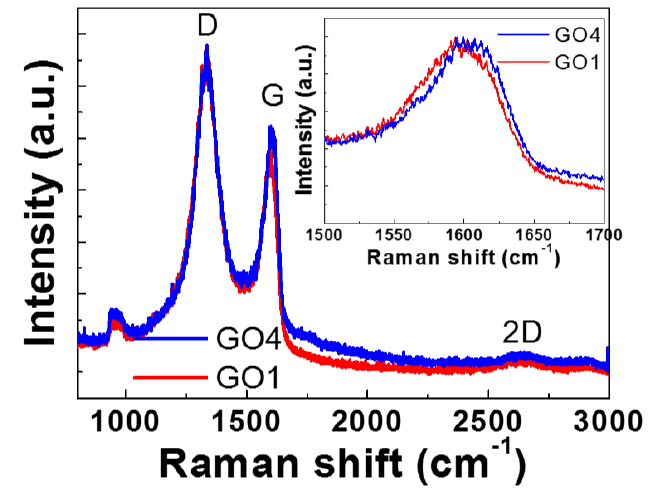
Figure 3. Raman spectra of the GO1 and GO4 samples. A magnified view of the G band is provided in the inset. The excitation wavelength in Raman measurements was located at 632.8 nm. The G peak of GO4 shifted to a higher wavenumber than that of GO1.